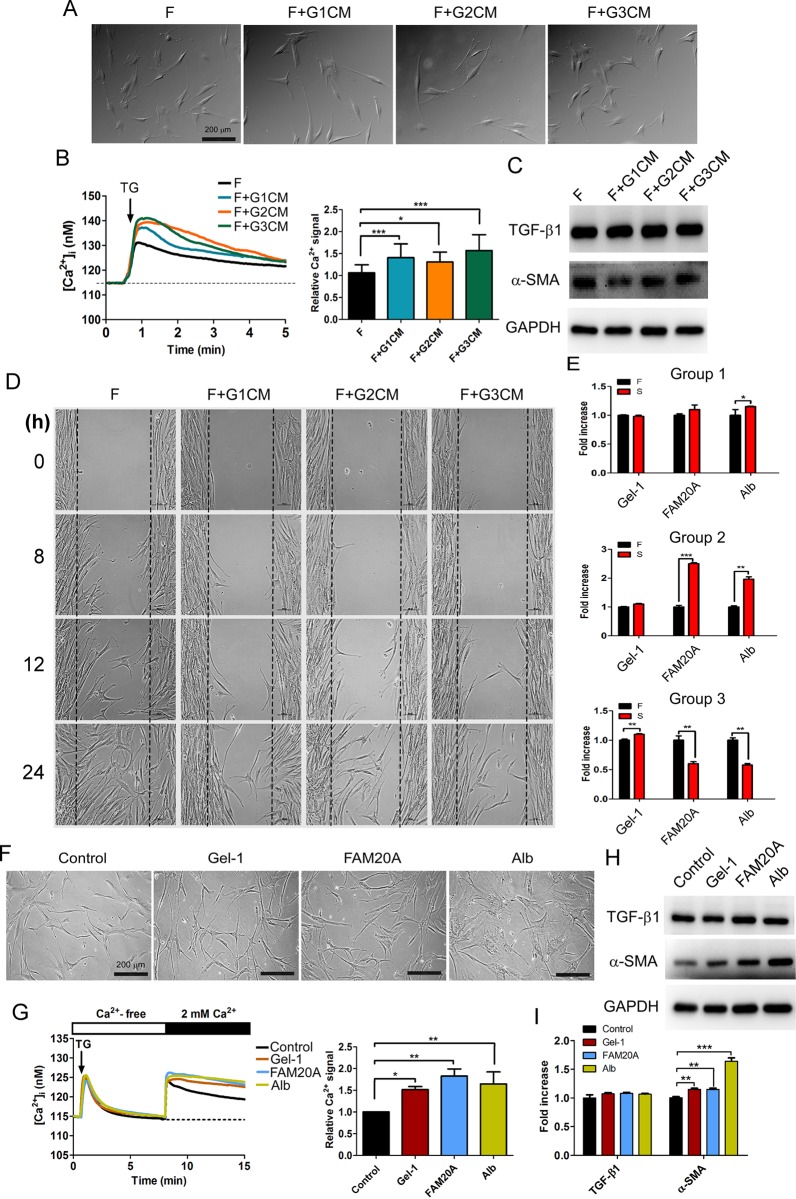
The differentiation of fibroblasts induced by exogenous factors was TGF-β1 independent.(A) Human dermal fibroblasts (F) from healthy people were treated with the conditioned medium of each group, and the alteration in cell morphology was then observed. The conditioned medium was obtained from each group of SSc fibroblasts after a one-day incubation and used to treat the fibroblasts (group 1 conditioned medium, G1CM; group 2 conditioned medium, G2CM; group 3 conditioned medium, G3CM). (B) Treatment with the conditioned medium from each group of SSc fibroblasts promoted the TG-induced Ca2+ influx. Right panel: the mean area under the intracellular Ca2+ response curves after TG was applied (n >120 cells, mean ± SD, *, p<0.05; ***, p<0.001). (C) Analysis of the expression levels of TGF-β1, α-SMA, and GAPDH after treatment with the conditioned medium for 24 h. (D) The conditioned media blocked the cell migration. (E) Three extracellular molecules, gelatin-1 (Gel-1), FAM20A, and human albumin (Alb), were screened by analysis with the IPA system, which identified the common components in the media from the three groups. Analysis of the expression of gelatin-1, FAM20A, and human albumin in the three groups by LC/MS (mean ± SD, *, p<0.05; **, p<0.01; ***, p<0.001). Treatment with gelatin-1 (0.25 ng/ml), FAM20A (1 μg/ml), and human albumin (2 mg/ml) in fibroblasts for 14 days and the subsequent effects on (F) cell morphology, (G) SOCE activity and (H) α-SMA expression. Right panel: the mean area under the intracellular Ca2+ response curves after the addition of extracellular CaCl2 (n >120 cells, mean ± SD, *, p<0.05; **, p<0.01). (I) The quantification of (H) protein expression is shown (data were normalized to the protein expression of the internal control, GAPDH; mean ± SD, **, p<0.01; ***, p<0.001).